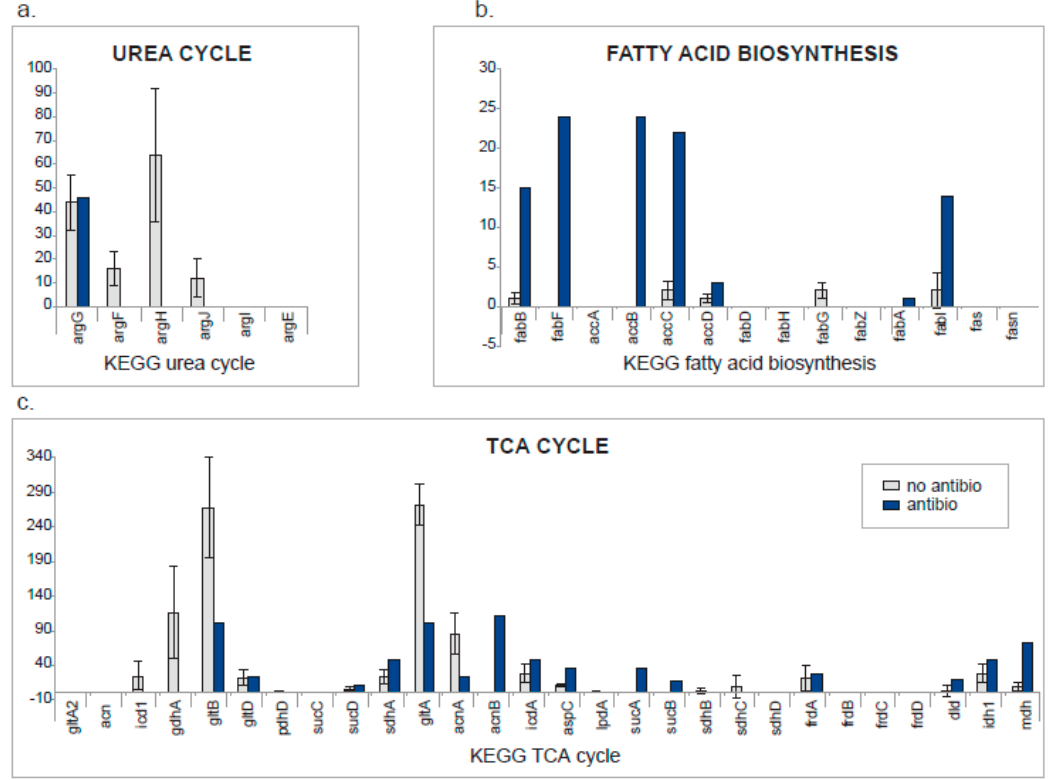
Figure 6. Comparison at the pathway level between infants with and without antibiotic treatment. For the three KEGG pathways showing differences between the two groups ( a ) urea cycle, ( b ) fatty acid biosynthesis and ( c ) TCA (tricarboxylic acid) cycle (a.k.a citric acid or Krebs cycle), the number of spectral counts for all proteins was calculated. For the infant treated with antibiotics, spectral counts detected for each protein are shown (blue bars). For the other infants, the average number of spectral counts and corresponding standard deviations are shown (grey bars).